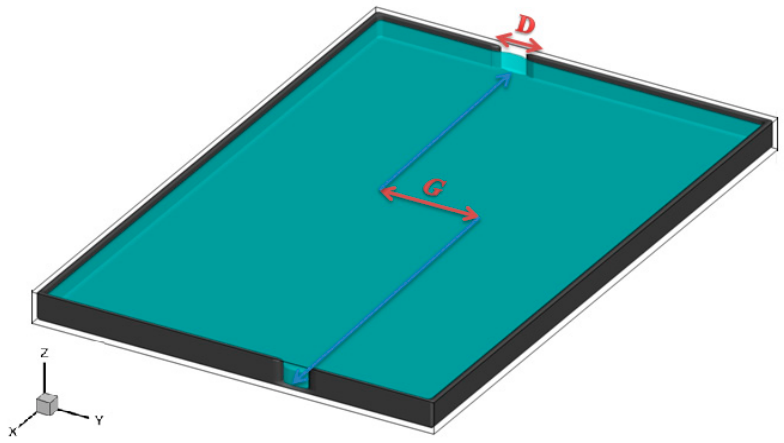
Figure 2. The positions of the inlet and outlet in the reservoir.